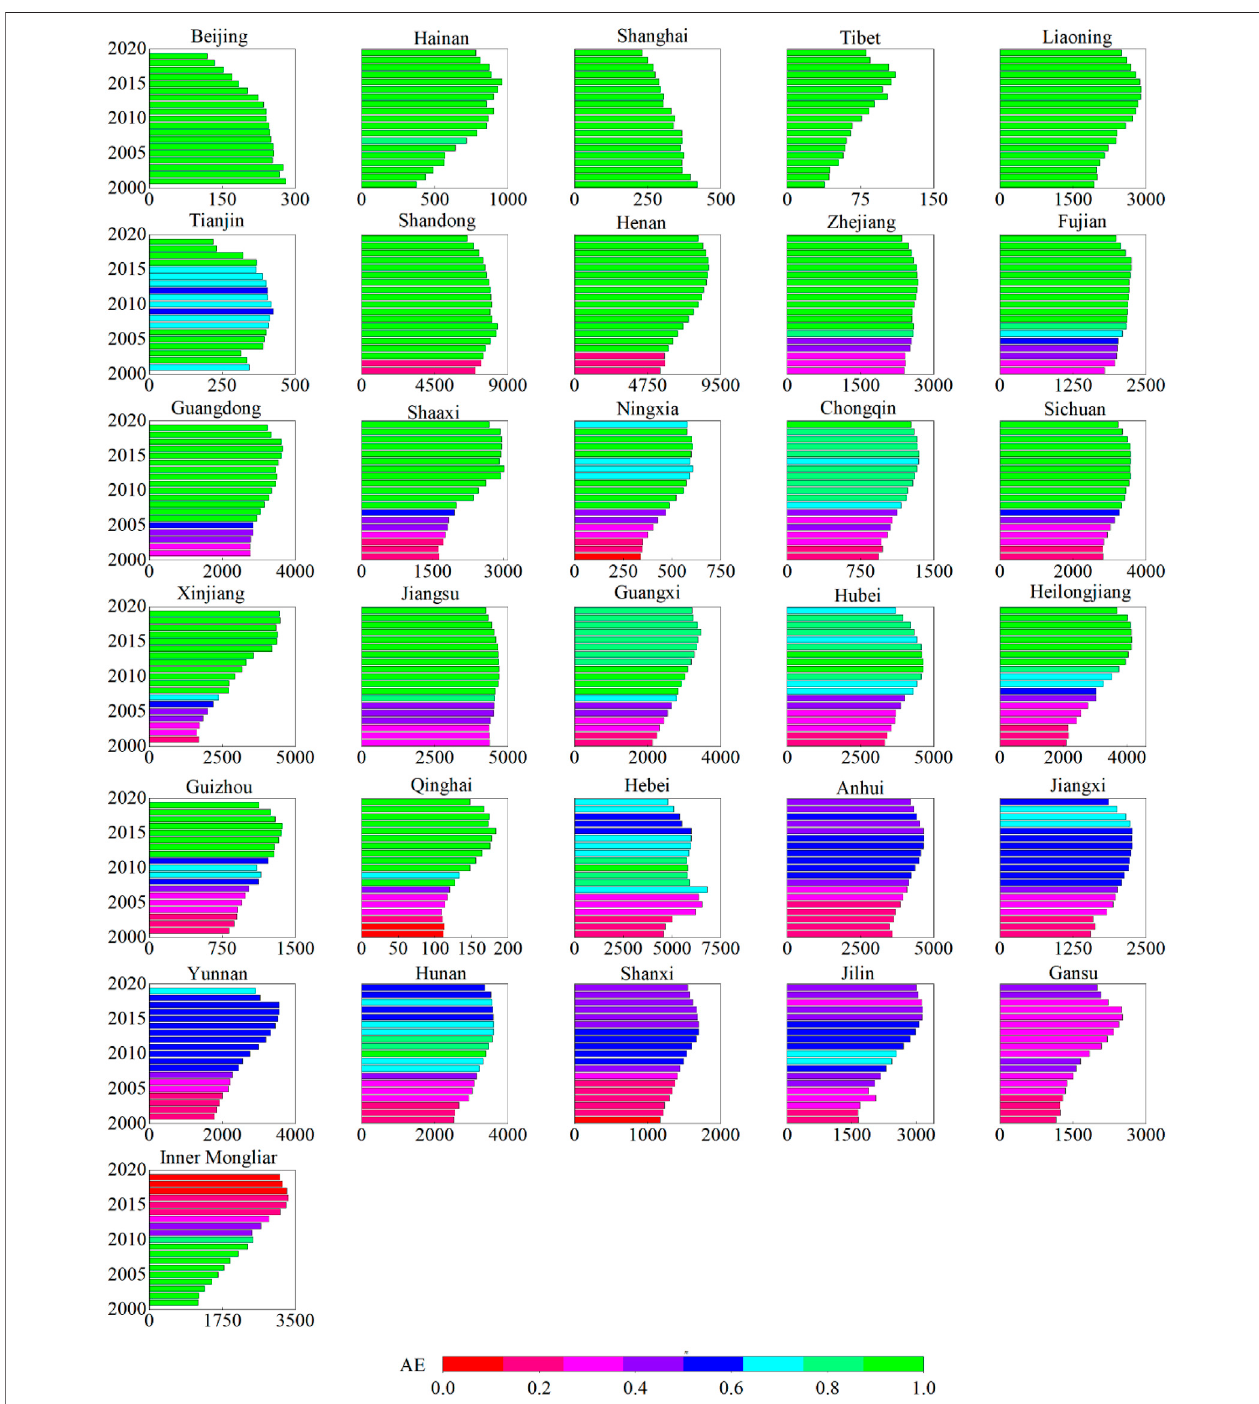
FIGURE 2 | Agricultural Eco-ef fi ciency in different provinces from 2001 –